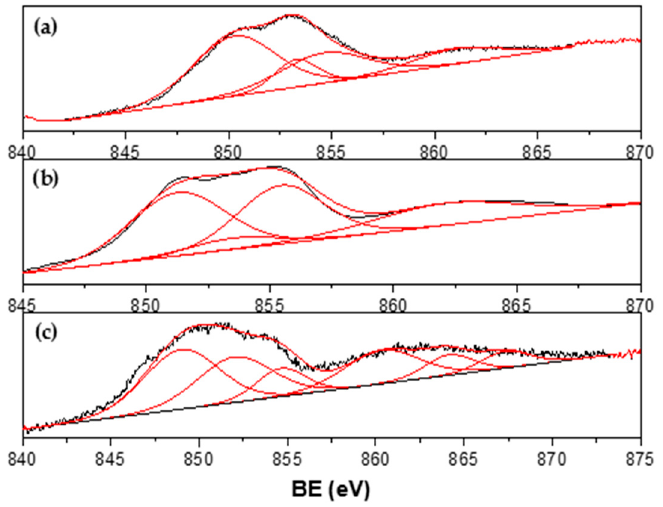
Figure 7. Ni 2p XPS spectra of ( a ) Ni 0.1 Co 0.9 / La 0.8 Ce 0.2 ; ( b ) Ni 0.4 Co 0.6 / La 0.8 Ce 0.2 ; and ( c ) Ni 0.7 Co 0.3 / La 0.8 Ce 0.2 .